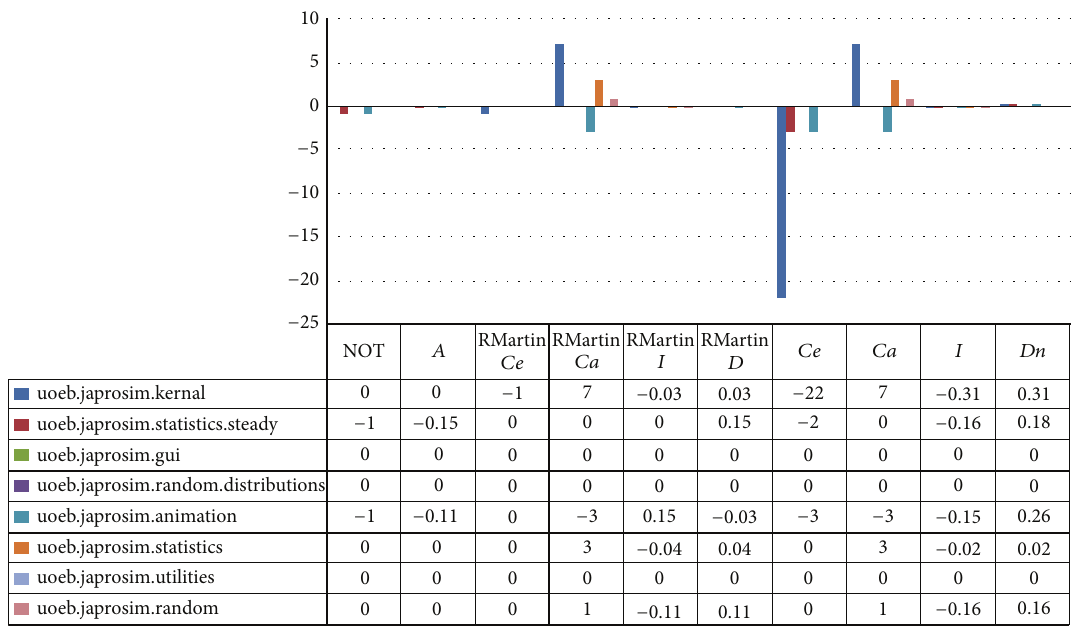
Figure 8: The difference in measurement results for both AO and OO Japrosim packages